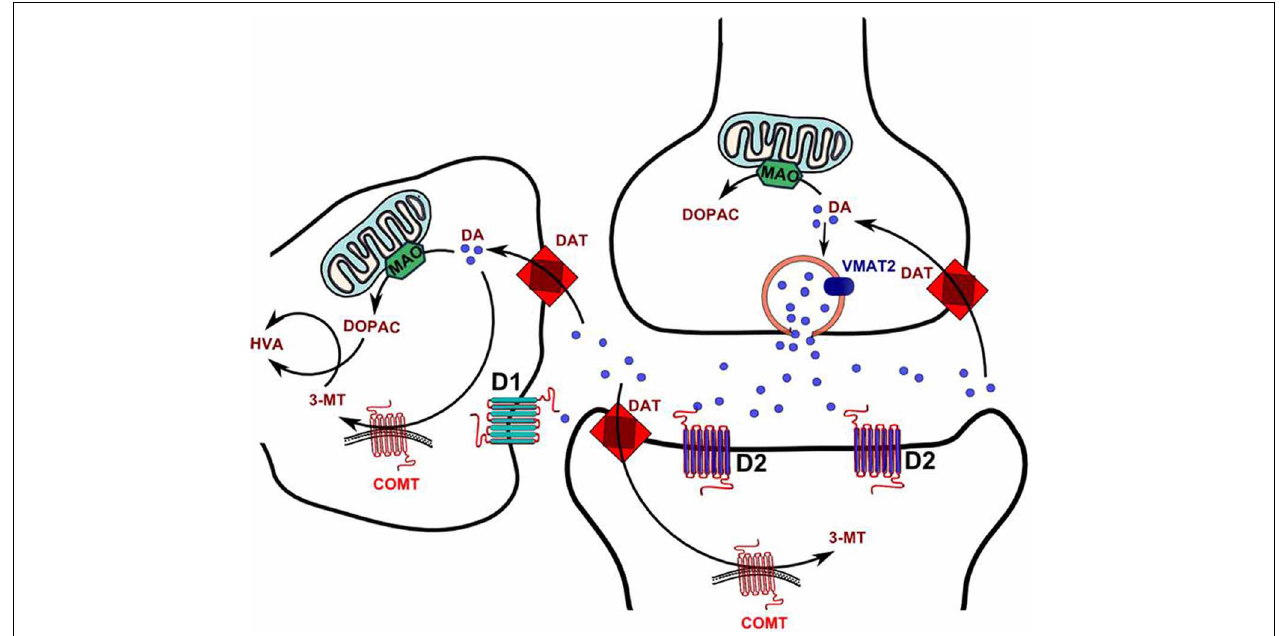
FIGURE 1 | Schematic diagram of DA synaptic metabolism. Abbrevations 3-MT, 3-Methoxytyramine; COMT, Catechol-o-methyltransferase; DA, DA; DAT, DA reuptake transporter; DOPAC, 3,4-Dihydroxyphenylacetic acid; HVA, Homovanillic acid; MAO, Monoamine oxidase.